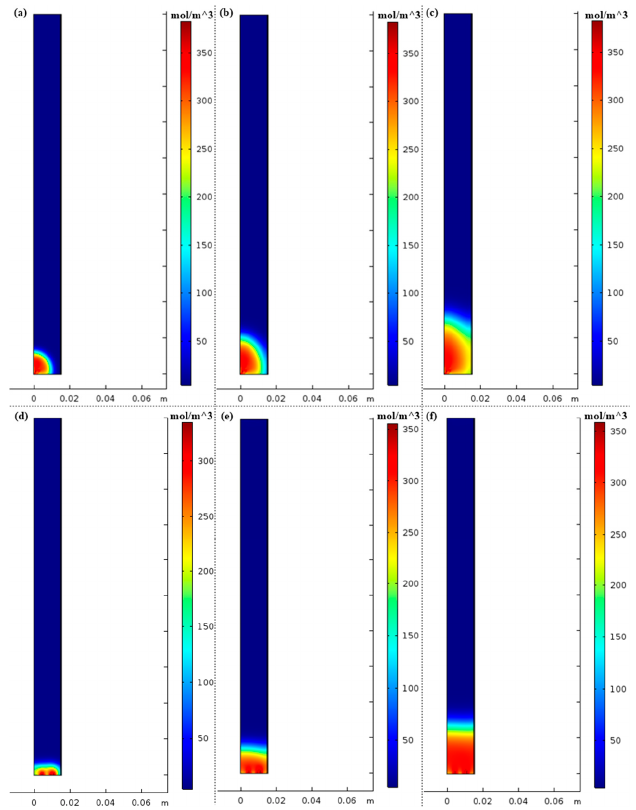
Figure 16. ( a ) N 2 concentration profile without inlet distributor at t = 1 s; ( b ) N 2 concentration profile without inlet distributor at t = 3 s; ( c ) N 2 concentration profile without inlet distributor at t = 6 s; ( d ) N 2 concentration profile with inlet distributor at t = 1 s; ( e ) N 2 concentration profile with inlet distributor at t = 3 s; ( f ) N 2 concentration profile with inlet distributor at t = 6 s.